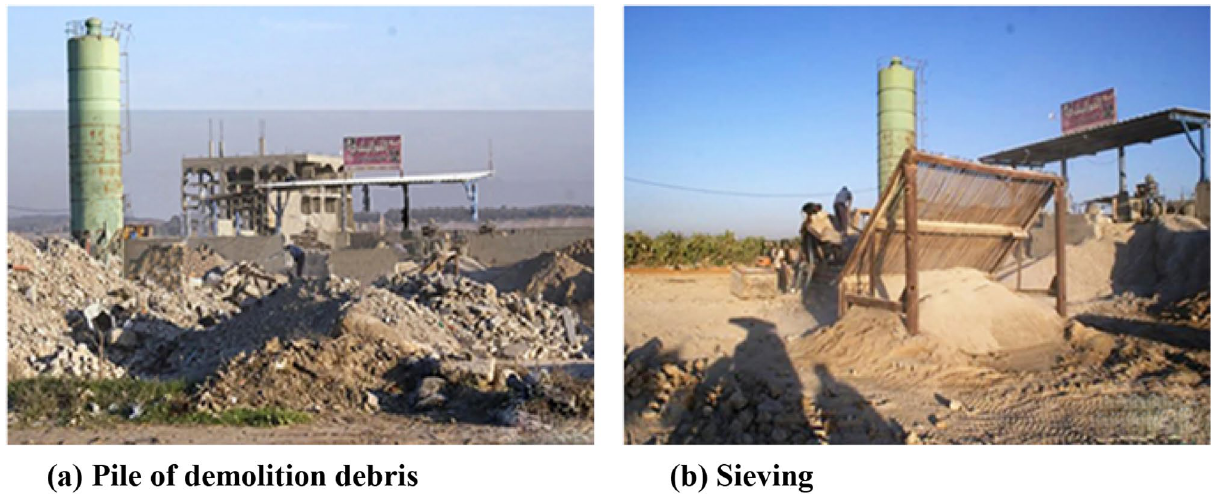
Figure 2. Example of ( a ) pile of demolition debris and ( b ) sieving in the Gaza Strip 19